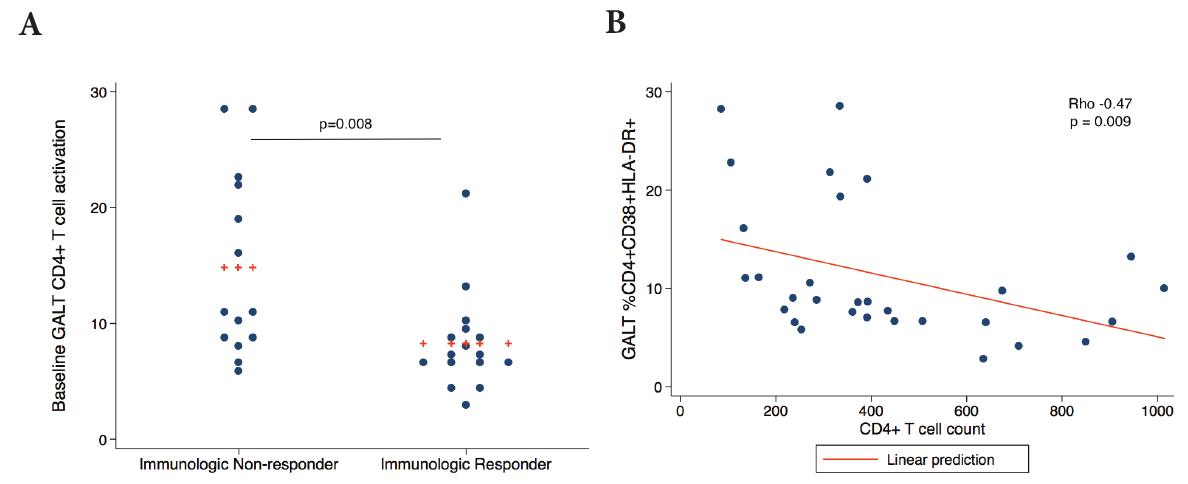
Figure 3. (A) Baseline levels of CD4 + T cell activation in rectal cells in immunologic non-responders and immunologic responders. (B) The correlation between the percentage of CD4 + CD38 + DR + T cells in the rectal lymphoid tissue and the peripheral CD4 + T cell count. A linear prediction line is shown in